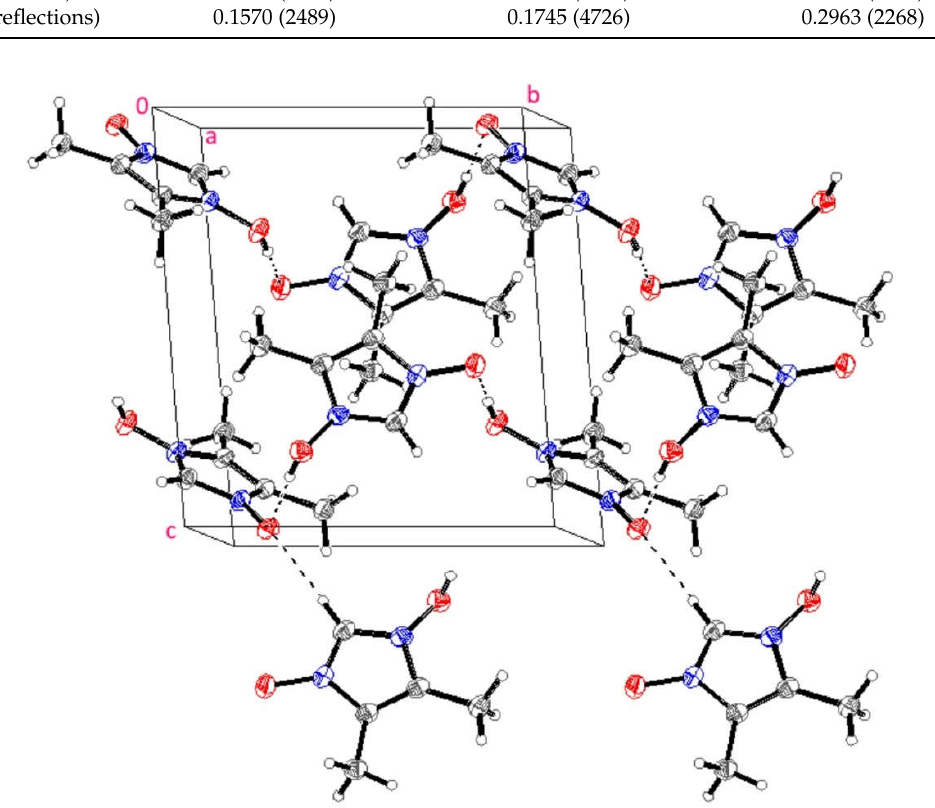
Figure 10. Ortep drawing of the independent unit with a numbering system for HIMO.